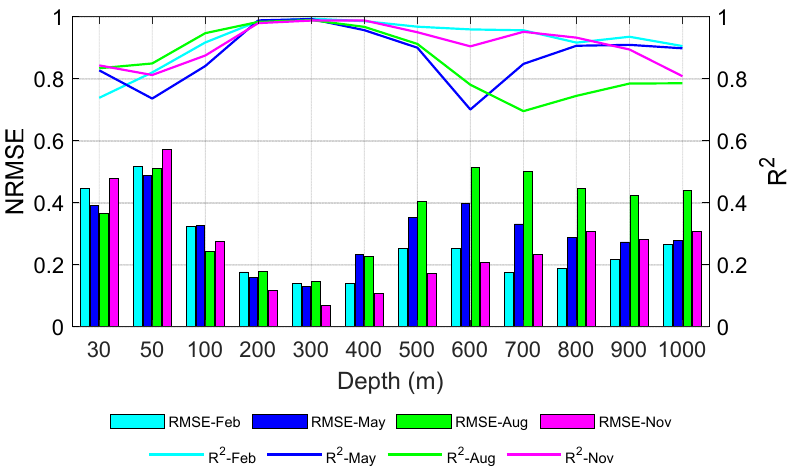
Figure 10. Seasonal performance of the Ens-ML model for ocean subsurface thermal structure estimation at different depths in the SCS in 2019. Cyan indicates February (winter), blue May (spring), green August (summer), and magenta November (autumn). Histograms display the NRMSE, and the lines display R 2 .